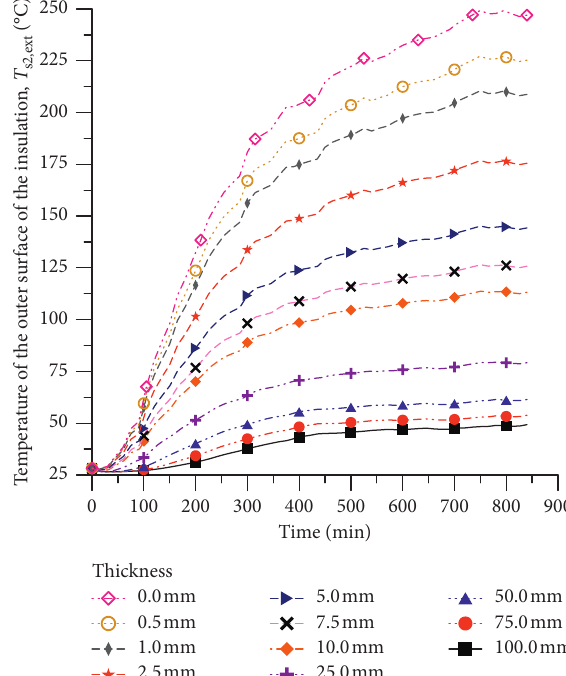
Figure 7: Surface temperature outside the insulation during the heating process for different ceramic fiber thicknesses.